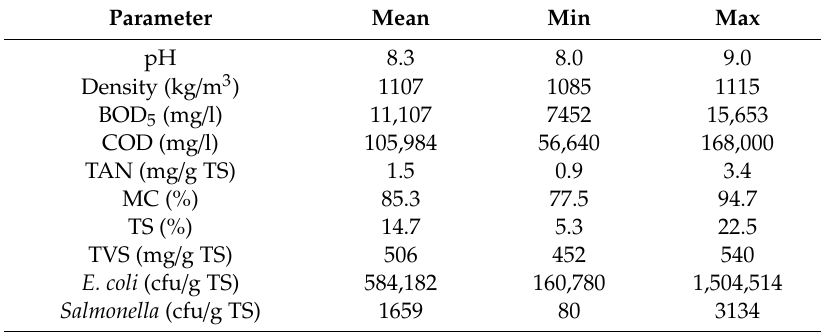
Table 2. Summary statistics of raw sludge characteristics. BOD: biochemical oxygen demand; COD: chemical oxygen demand; TAN: total ammoniacal nitrogen; MC: moisture content; TS: total solids; TVS: total volatile